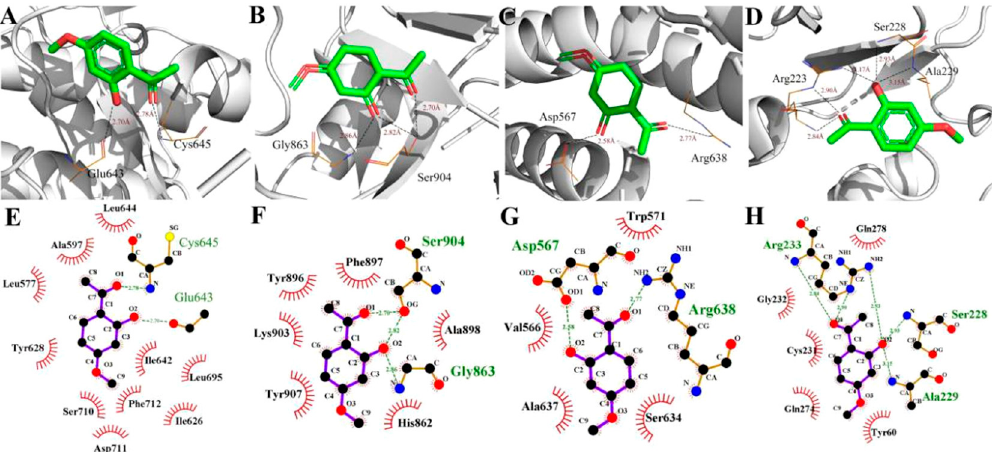
Figure 7. Detailed view of the binding interaction between Paeonol and four representative receptors. ( A , E ) ERN1-Serine / threonine-protein kinase / endoribonuclease IRE1. ( B , F ) PARP1-Poly [ADP-ribose] polymerase-1. ( C , G ) PLEC-Plectin. ( D , H ) PTPN22-Trypsin-1.